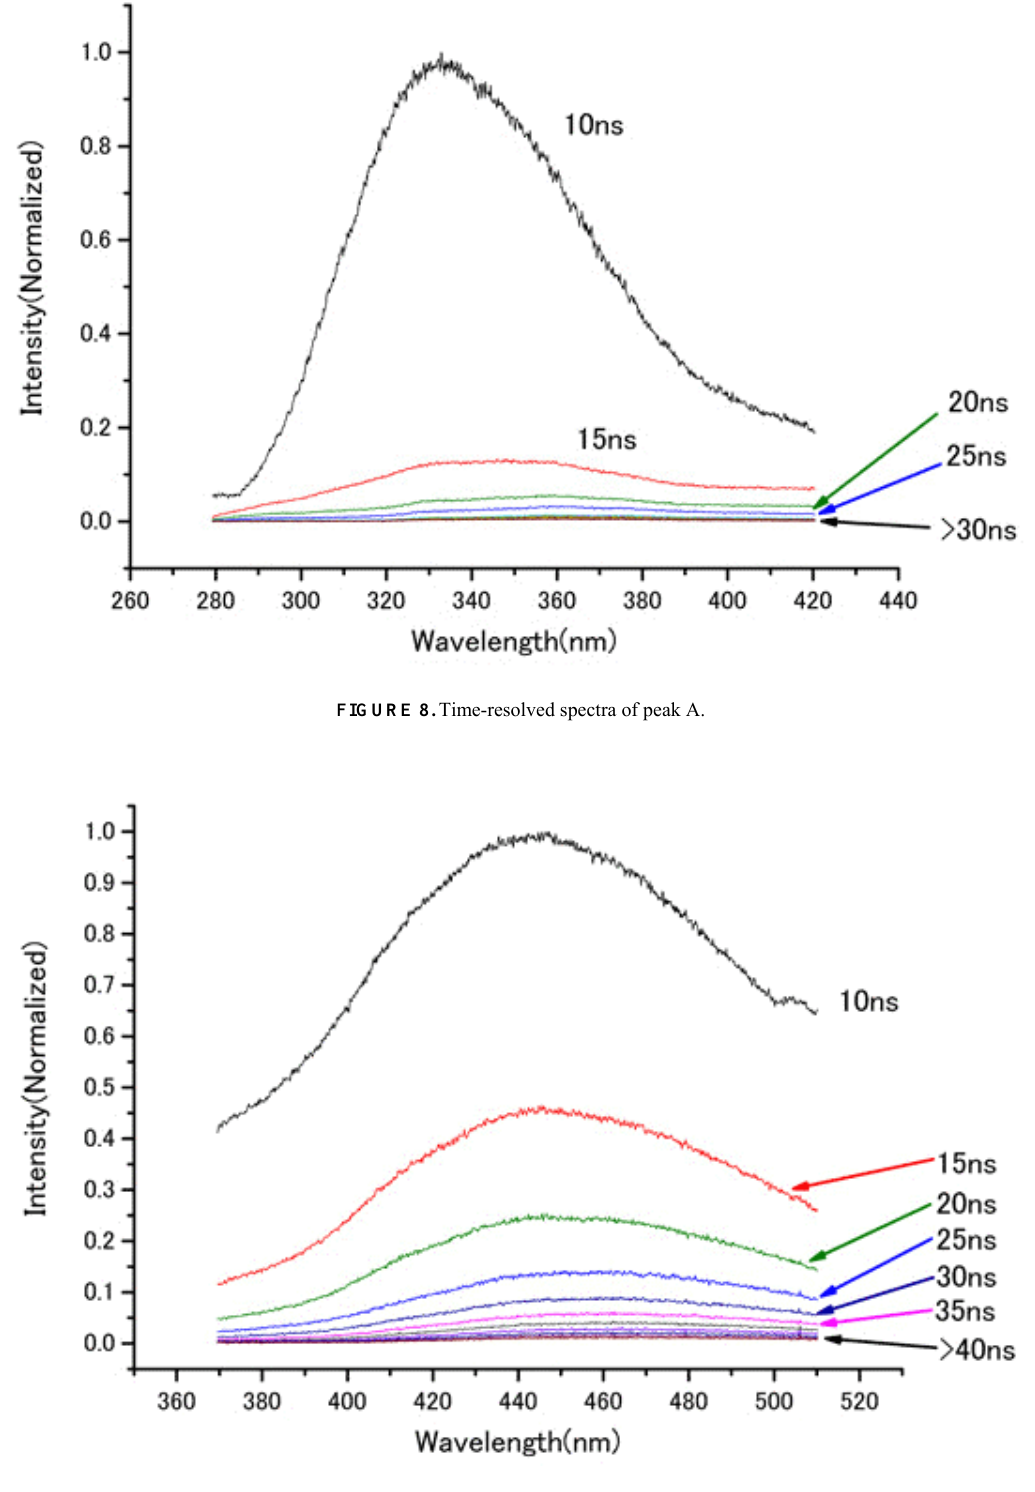
FIGURE 9. Time-resolved spectra of peak